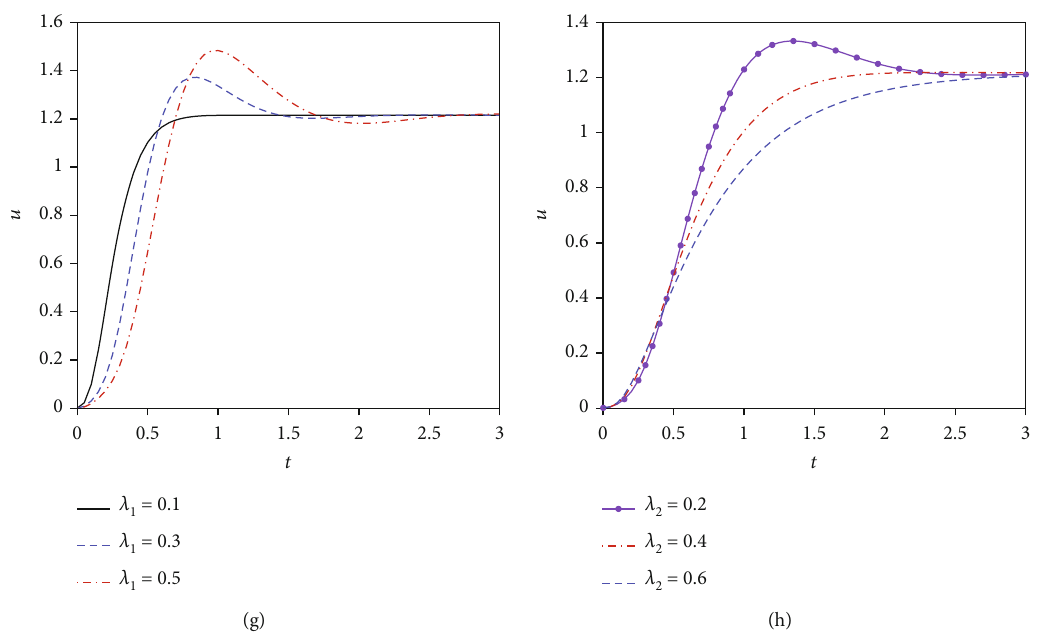
Figure 4: A dimensionless velocity distribution in a circular microchannel ( λ